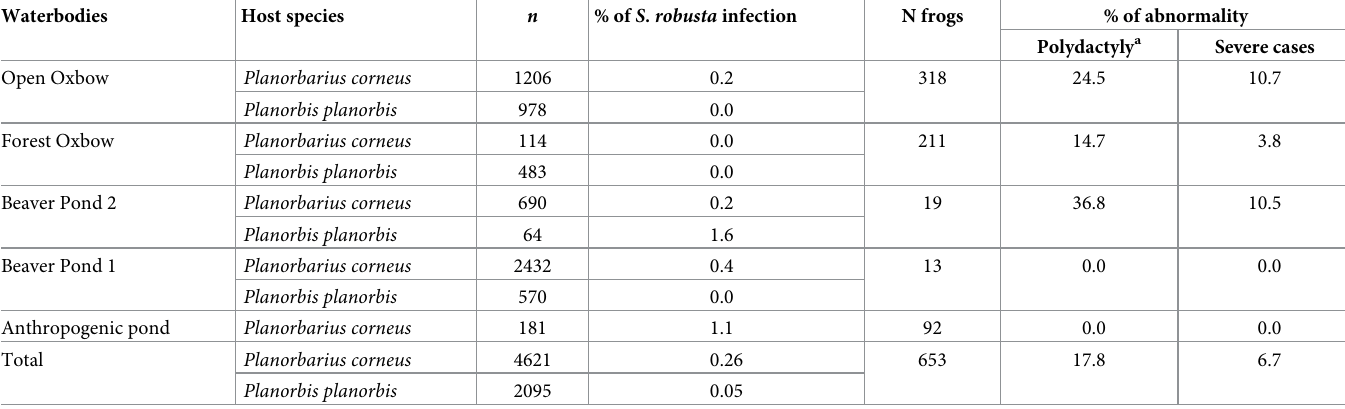
Table 8. Occurrence (%) of Strigea robusta and abnormal individuals of the marsh frog, Pelophylax ridibundus , in waterbodies examined.